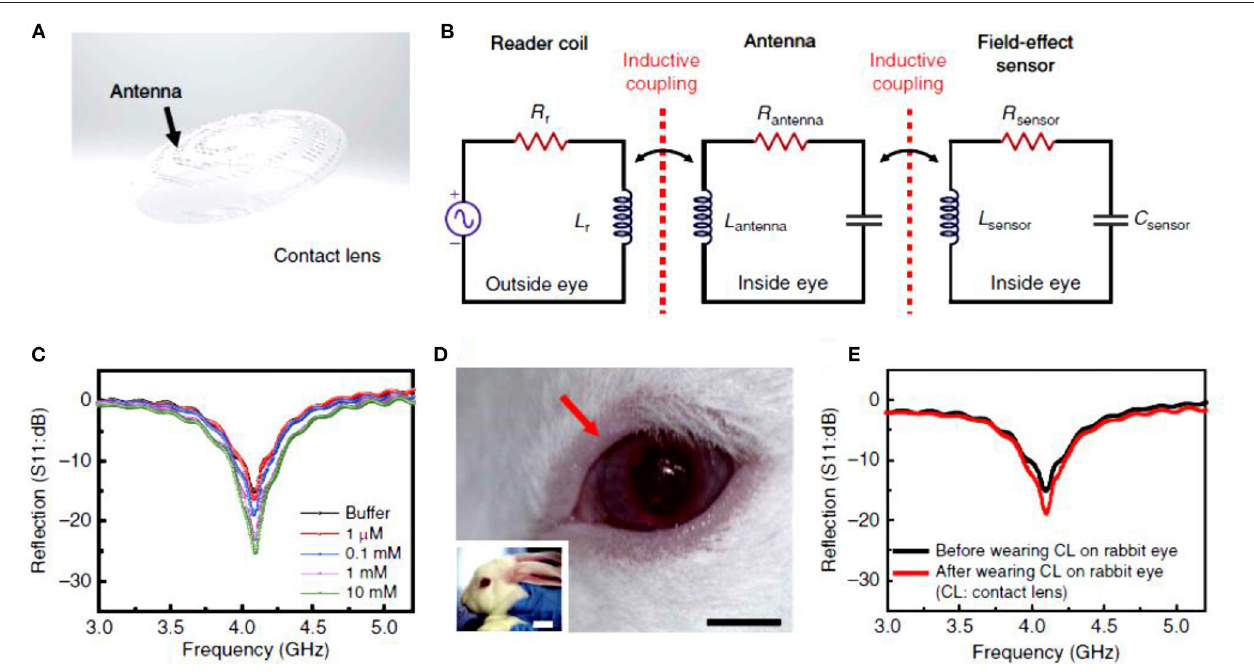
FIGURE 4 | Smart contact lenses for wireless glucose detection. (A–E) Electrochemical sensor integrated with a contact lens: (A) schematic illustration of the transparent glucose sensor integrated in the contact lens, (B) schematic illustration of the reading circuit in the wireless sensing mode, (C) wireless glucose measurements in the glucose range of 1–10mM, (D) photographs of the smart contact lens placed on rabbit eyes, and (E) wireless glucose detection by the smart contact lens in vitro and in vivo